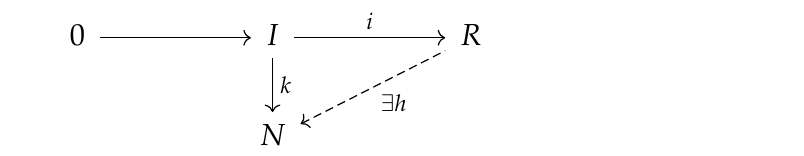
Figure 3. Composition structure of a diagram for a normal injective R -hypermodule, using hyperide- als